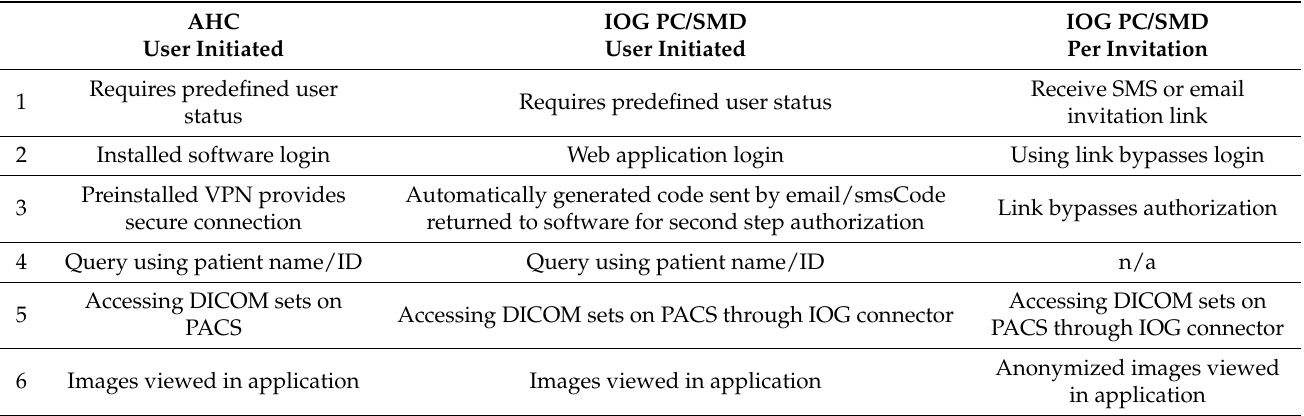
Table 1. User query initiated DICOM access using either AHC or IOG.